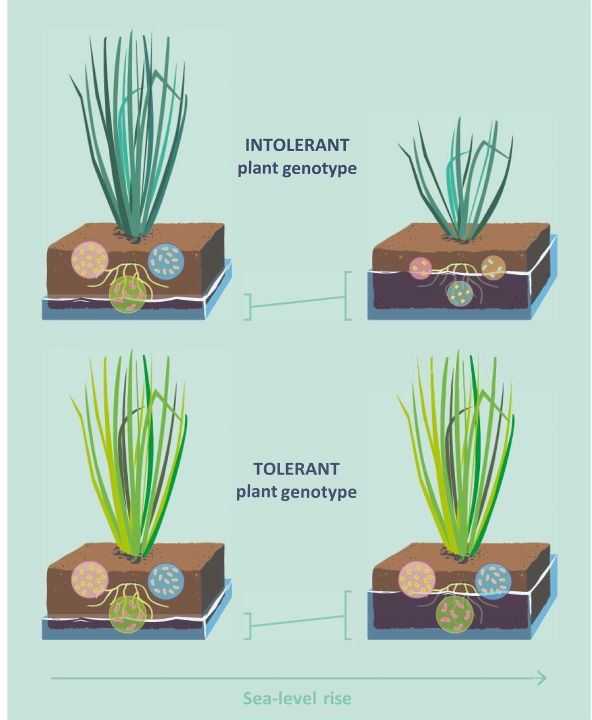
Figure 1. Conceptual diagram illustrating the hypothesis that ef- fects of sea-level rise on soil microbial functioning are mediated by intraspecific genetic variation in plants. Two genotypes of the dom- inant tidal wetland grass Elymus athericus have been identified, an intolerant plant genotype, found in high-marsh environments, and an tolerant plant genotype, found in low-marsh environments. The tolerant genotype shows no reduction of aboveground biomass even in response to extreme increases in flooding frequency (Reents et al., 2021). Given the overriding control of plant aboveground pro- cesses on microbial functioning in tidal wetland soils, we hypoth- esized that the tolerant genotype buffers the response of the soil microbial community to increasing flooding